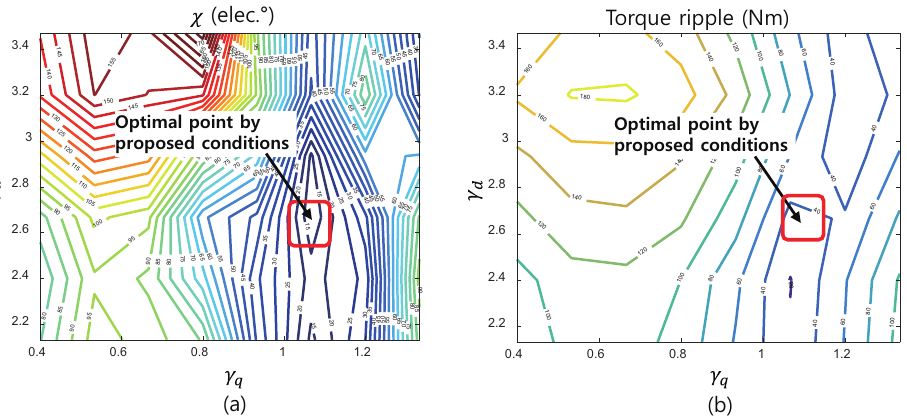
Figure 7. Optimization results via subdomain analysis: ( a ) level plot of χ and ( b ) level plot of torque ripple. FEA for torque ripple analysis is set as following: 19,158 meshes, the rotation angle per step is 0.25 ◦ , the rotation angle is from 0 to 15 ◦ , and 61 time-steps. So, the computation time for FEA is 270 s